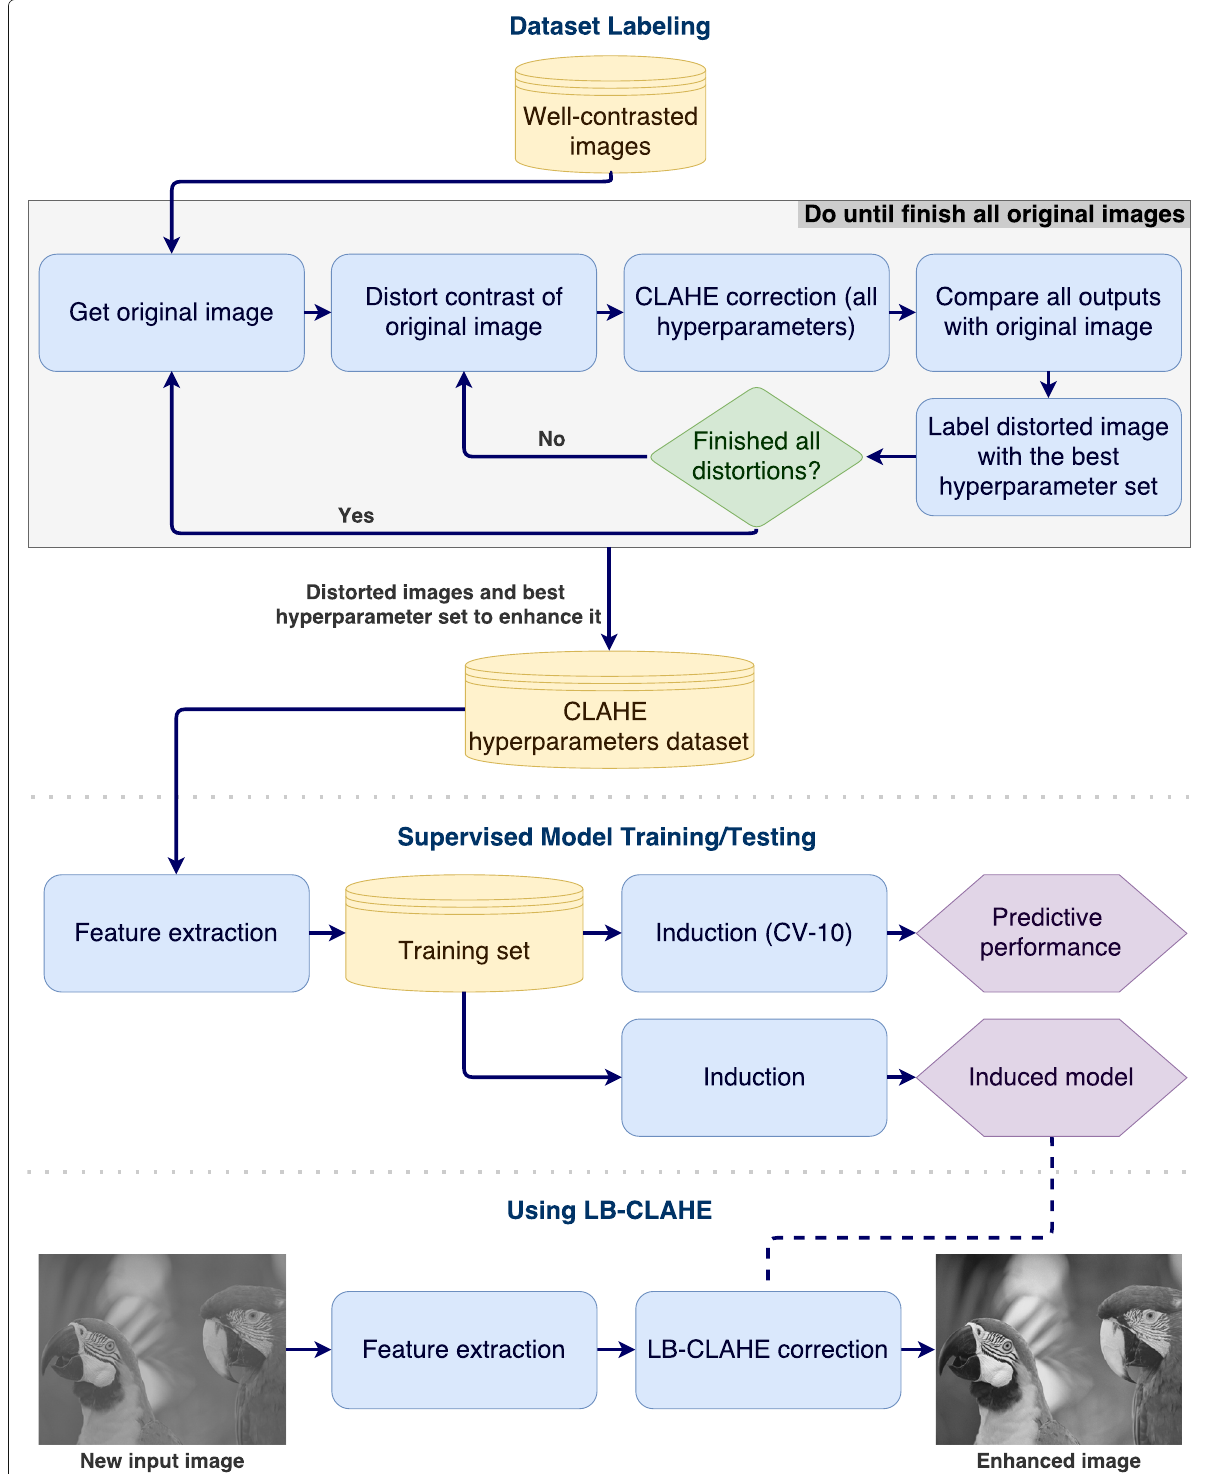
Fig. 2 Overall flow of the proposed approach and experimental